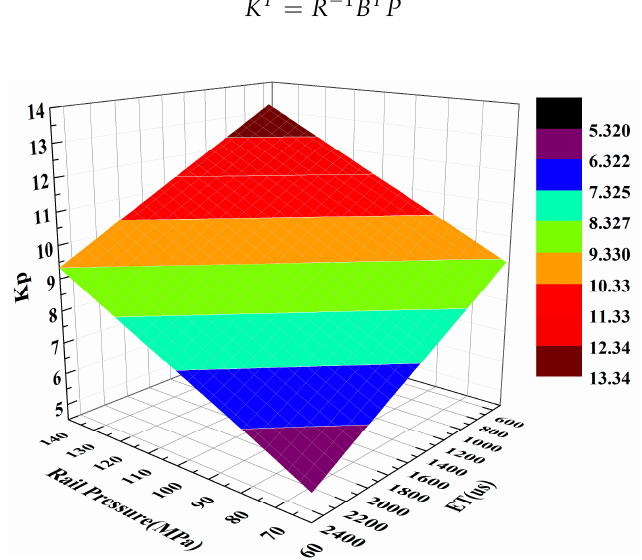
Figure 6. K p distribution at different rail pressures and ET.